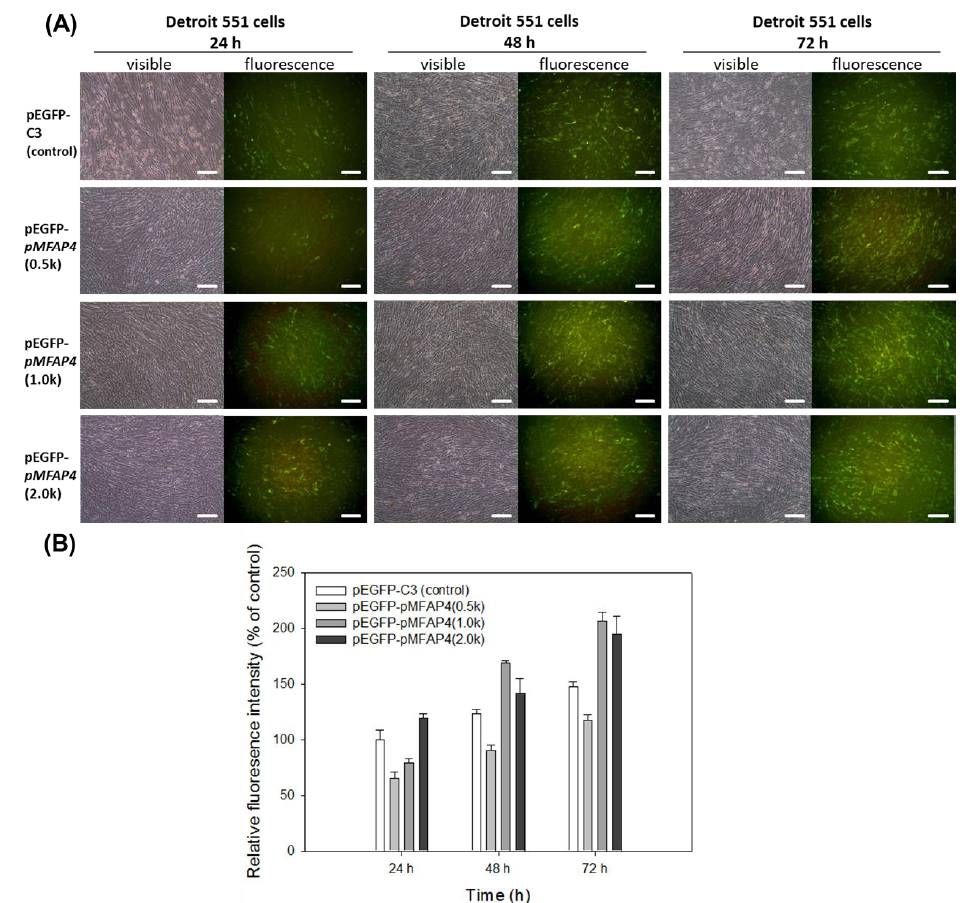
Figure 3. TheexpressionofpEGFP- pMFAP4 plasmidsinhumanfibroblastDetroit551cells. ( A )Fluorescence Figure 3. The expression of pEGFP- pMFAP4 plasmids in human fibroblast Detroit 551 cells. ( A ) images. Scale bar = 100 µ m. ( B ) Relative fluorescence intensity. Data are presented as means ± Fluorescence images. Scale bar = 100 μm. ( B ) Relative fluorescence intensity. Data are presented as means ± SE.